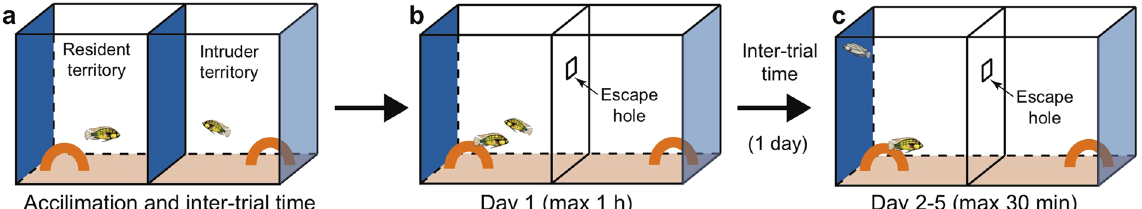
Figure 1. A resident-intruder paradigm was used to induce repeated social defeat in Astatotilapia burtoni males. ( a ) A 37.85 L tank was divided in two compartments by an opaque blue barrier, and views of neighbouring tanks were obstructed. One fish was allowed to acclimate to each territory for 2 days. ( b ) On the morning of the trial, the blue barrier was removed between the two compartments revealing a